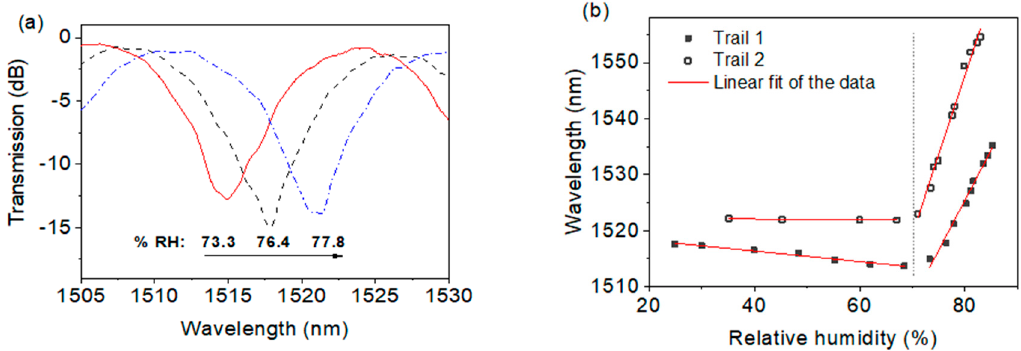
Figure 26. ( a ) Spectral response of the MFC humidity sensor for different humidity values; ( b ) linear fits of the two MFC humidity sensors over a humidity range of 25–85% RH [124]. Reproduced with permission from Lin Bo, Pengfei Wang, Yuliya Semenova, Gerald Farrell, Optical Microfiber Coupler Based Humidity Sensor with a Polyethylene Oxide Coating; published by Wiley Online Library, 2015.